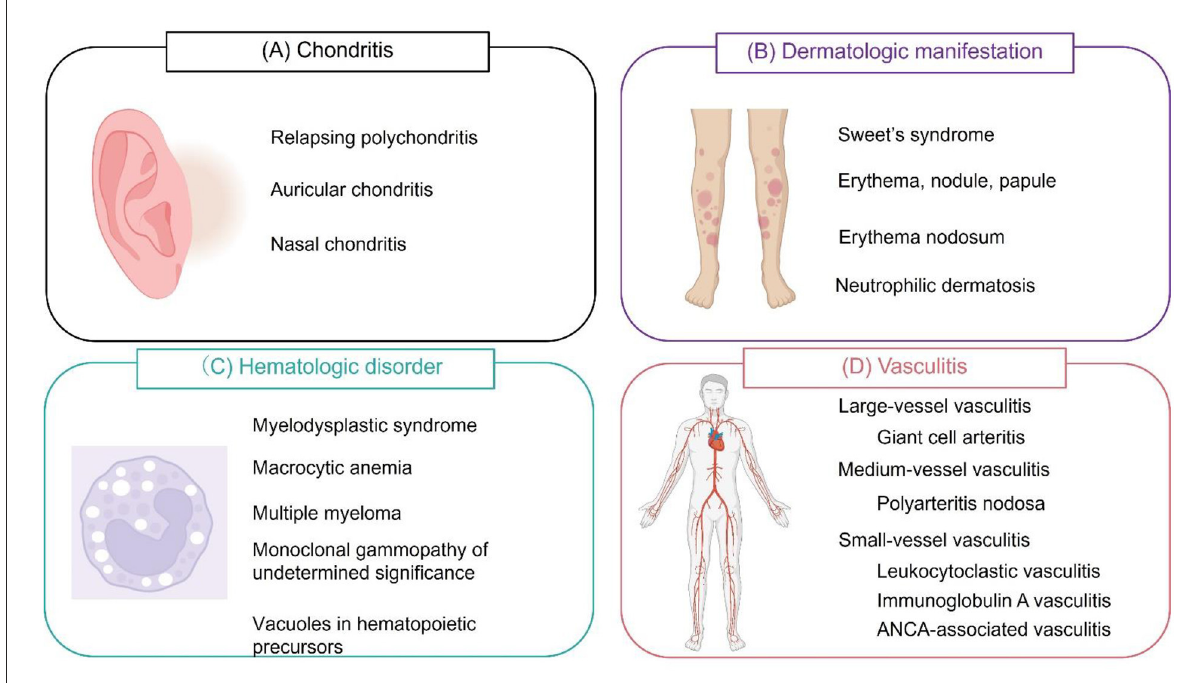
FIGURE1 Symptoms of VEXAS syndrome. (A) Relapsing polychondritis (auricular and/or nasal chondritis) is one of the most common manifestations of VEXAS (vacuoles, E1 enzyme, X-linked, autoinflammatory, somatic) syndrome. (B) Dermatological manifestations include Sweet’s syndrome, erythema, nodules, papules, erythema nodosum, and panniculitis. These lesions are histologically characterized by neutrophilic dermatosis. (C) Hematological manifestations include myelodysplastic syndrome, macrocytic anemia, multiple myeloma, and monoclonal gammopathy of undetermined significance. Vacuole formation is characteristic of hematopoietic and myeloid precursor cells. (D) VEXAS syndrome can cause inflammation of blood vessels of any size. Cranial or extracranial giant cell arteritis, polyarteritis nodosa, leukocytoclastic vasculitis, immunoglobulin A vasculitis, and antineutrophil cytoplasmic antibody (ANCA)-associated vasculitis can be observed. Leukocytoclastic vasculitis is the most common type of vasculitis.